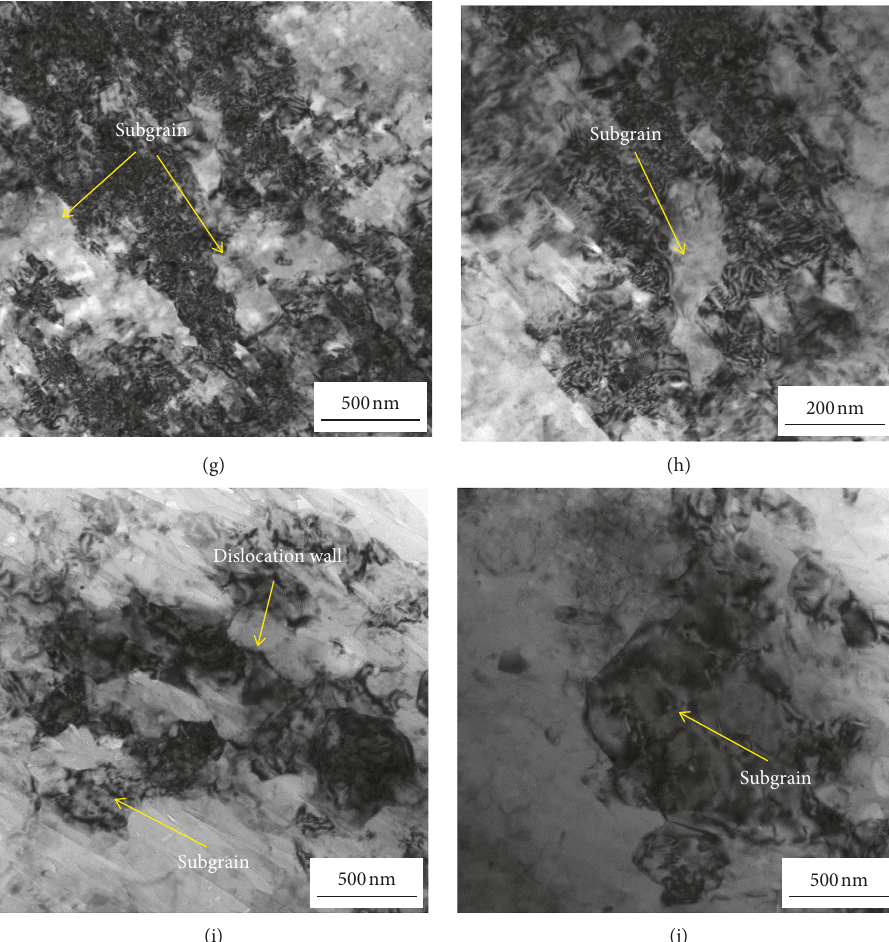
Figure 3: TEM images of the cold-rolled specimen after hot rolling under different temperatures. (a, b) 100 ° S ; (c, d) 150 ° S ; (e, f) 200 ° S ; (g, h) 250 ° S ; (i, j) 300 ° S